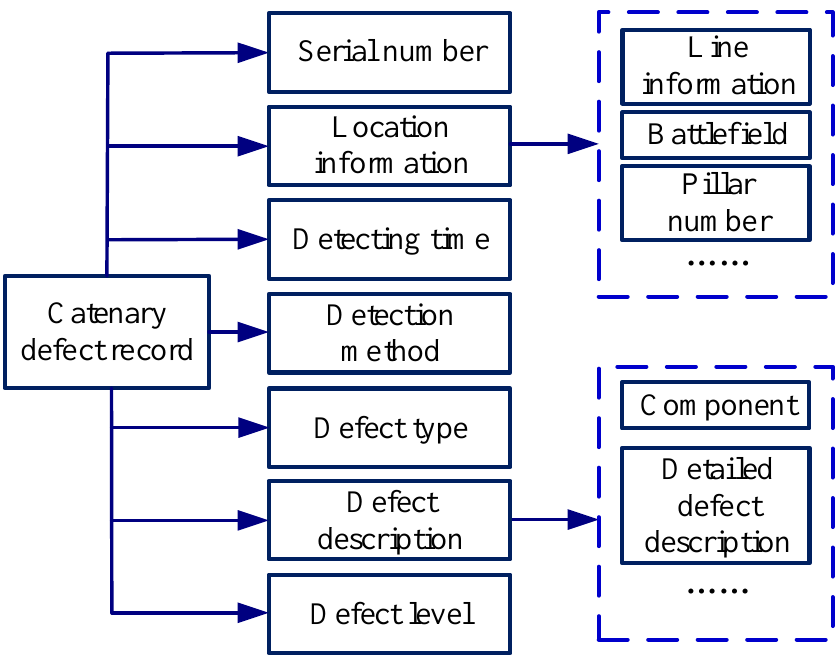
Figure 4. The content of the catenary defect